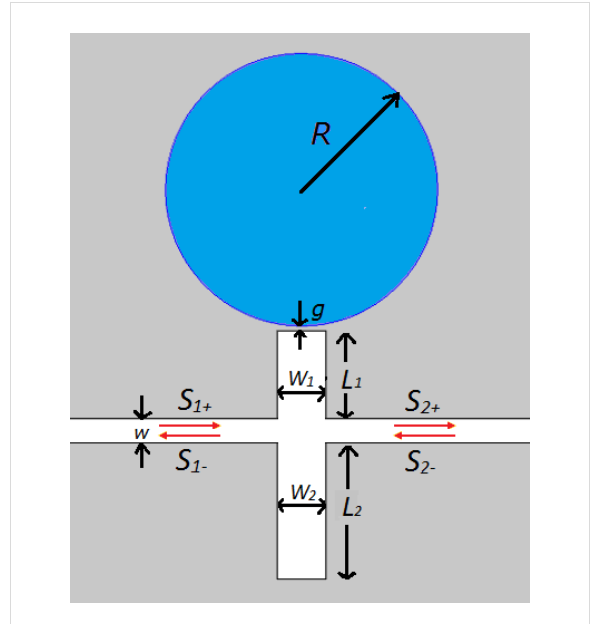
Figure 1: Schematic diagram of the MDM waveguide–resonator struc- ture. The width of the waveguide is W and the radius of the disk is R . L 1 , L 2 , and W 1 , W 2 denote the length and the width of two stubs, re- spectively. The coupling distance between the disk resonator and the upper stub is g